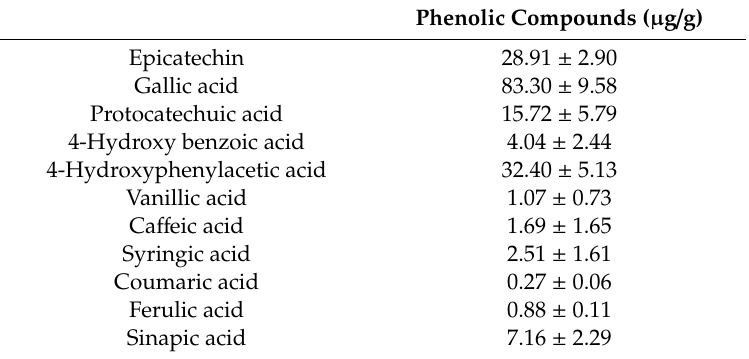
Table 5. Phenolic profile of BSG extract obtained in optimal conditions (results were expressed on a dry matter